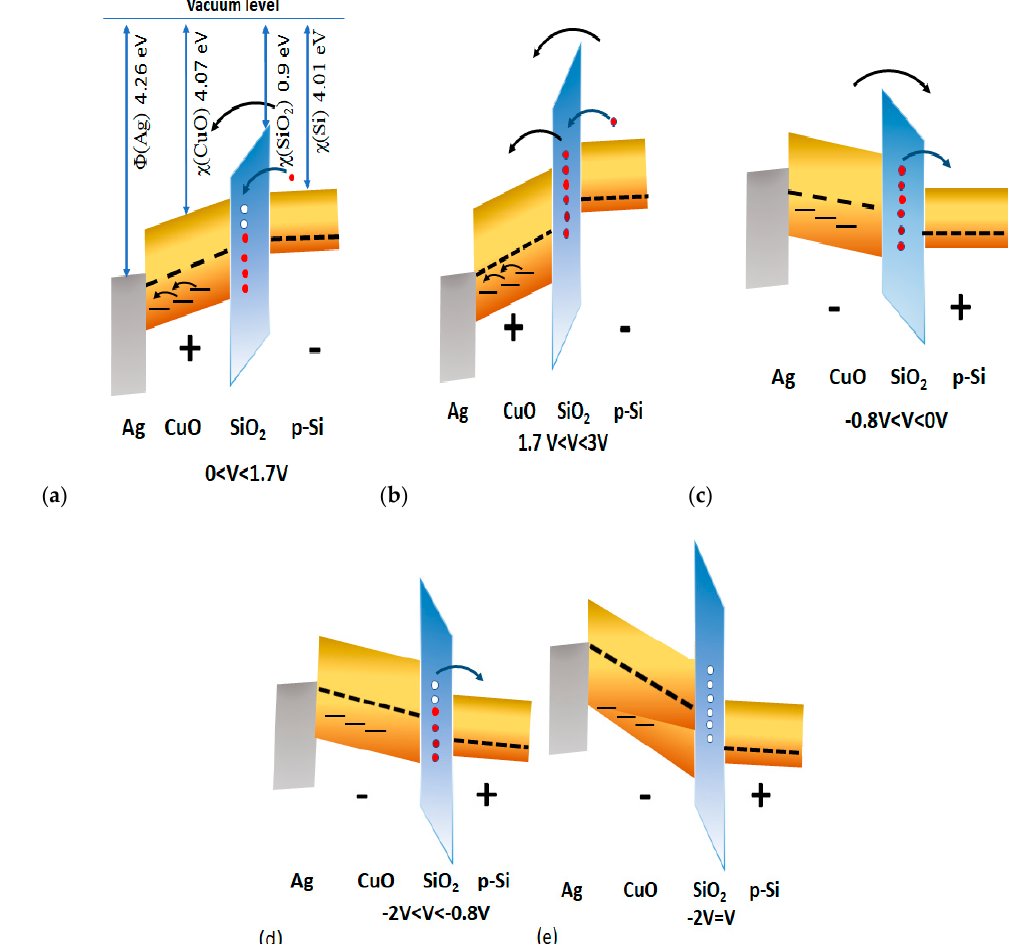
Figure 6. The I-V characteristics of Ag/CuO/ITO.